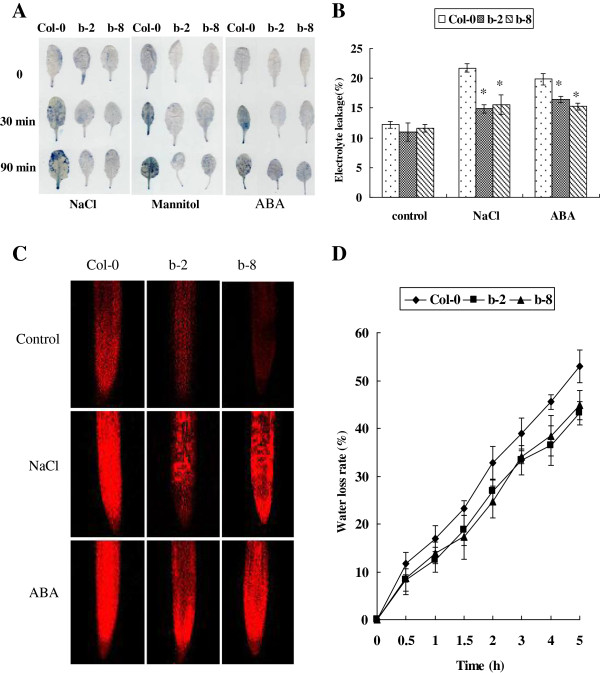
The constitutive expression of ThbZIP1 decreases cell death and water loss rate under stress conditions. A: Cell death staining with Evans blue before (Control) and after the treatment of NaCl, mannitol, or ABA. B: Comparison of electrolyte leakage between Col-0 and ThbZIP1 transformed plants. C: Assay of cell death between transgenic and Col-0 plants using propidium iodide (PI) fluorescence staining. D: Transpirational water loss rate analyses in Col-0 and ThbZIP1 transformed plants. All experiments were repeated three times. Data are means ± SD from three independent experiments. * Significant (t test, P < 0.05) difference compared with Col-0 plants.